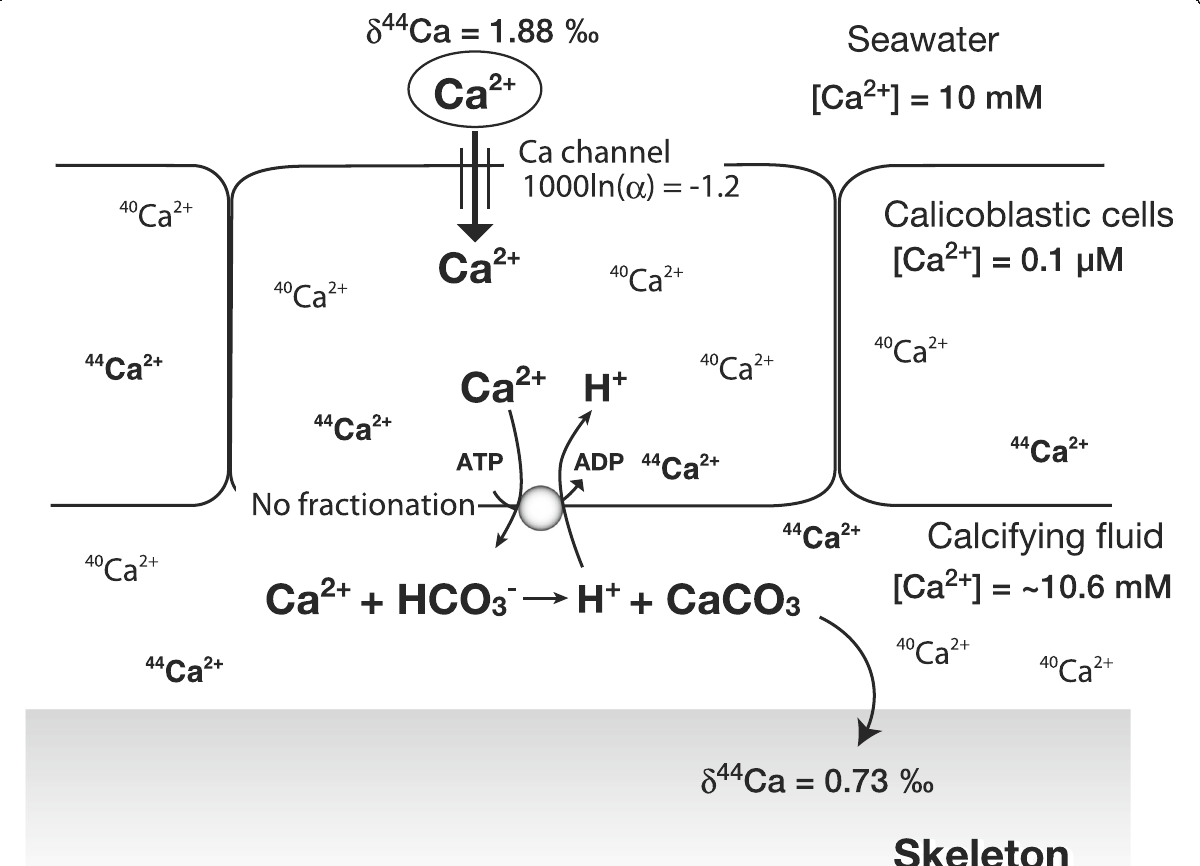
Fig. 10 Schematic diagram of coral calcification in terms of Ca 2+ transport. δ 44 Ca values of 1.88 ‰ and 0.73 ‰ are reported for seawater (Hippler et al. 2003) and coral skeletons (as the mean value of all data) (Inoue et al. 2015), respectively. The value of − 1.2 ‰ represents the typical fractionation at the Ca-channel (Wiegand et al. 2005; Böhm et al. 2006; Gussone et al. 2006). Typical concentrations of Ca 2+ in seawater, calicoblastic cells, and calcifying fluid are presented based on the reports of Al-Horani et al. (2003) for seawater and the calcifying fluid, and of Carafoli (2004) and Saris and Carafoli (2005) for the